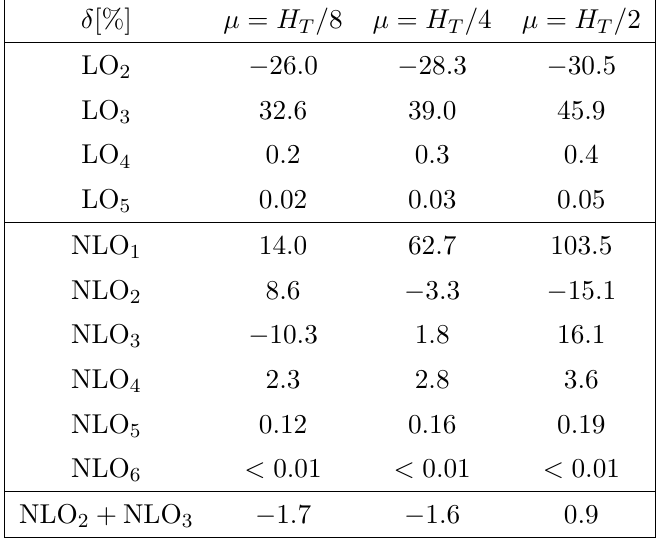
production, at variance with most of the other production processes studied in the litera- ture, quoting the relative size of NLO (cid:17) NLO or NLO corrections without specifying 2 3 EW the QCD-renormalisation and factorisation scale is simply meaningless. Moreover, (cid:14) NLO 2 and (cid:14) corrections can separately be very large, easily reaching (cid:6) 15% (depending on NLO 3 the value of (cid:22) ). Surprisingly, for our central value of the renormalisation and factorisation scales, the (cid:14) and (cid:14) are almost zero, 9 particularly for 13 TeV. On the other hand, NLO 2 NLO 3 if we had taken H = 2 or even m as our central scale choice, the NLO and NLO correc- 2 3 T t (cid:22) tt (cid:22) t tions relative to the LO , (cid:14) and (cid:14) , would have been much larger. Still, even for the 1 NLO 2 NLO 3 central value (cid:22) = H = 4, the corrections are much larger than foreseen, especially for (cid:14) T NLO 3 which naively is expected to be of order (cid:11) 3 (cid:11) 2 =(cid:11) 4 = (cid:11) 2 =(cid:11) (cid:24) 0 : 1% level. On the other s s s